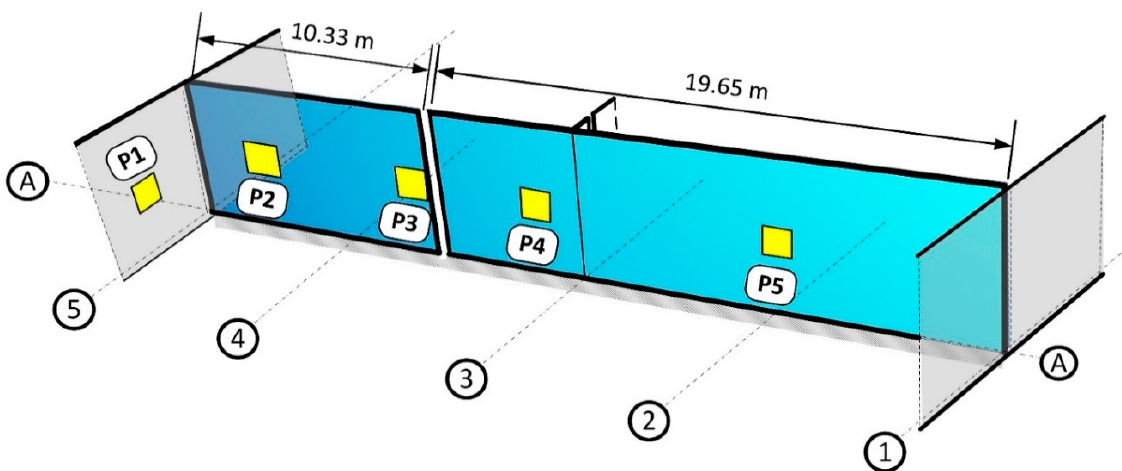
Figure 8. Places where electromagnetic, radar and ultrasonic tests were